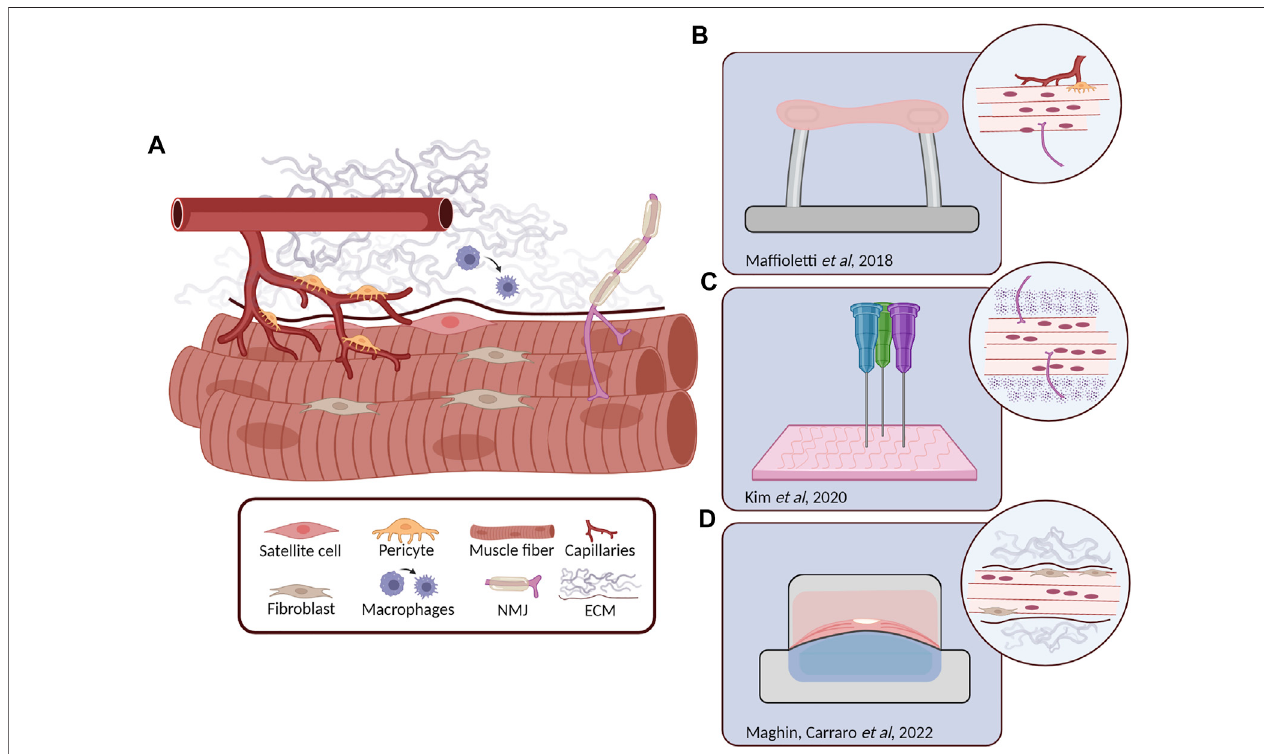
FIGURE2| Skeletalmuscle(SkM)structureandrelevant3Dtissueengineeredmodels. (A) SchematicrepresentationofthedifferentcelltypescomposingtheSkM tissue. Myo fi bers are surrounded by ECM proteins, satellite cells are retained underneath the basal lamina, fi broblasts are in close contact with myo fi bers as the motor neurons that form the neuromuscular junction (NMJ), while pericytes are coming from blood vessels. In the presence of muscle damage, macrophages are recruited to the site of injury where they differentiate from M1 to M2. (B) Human induced pluripotent stem (hiPS) derived cells (including myo fi bers, pericytes, endothelial cells andMN)embeddedina fi brinhydrogelmaintainedintensionbetweentwopillars.Microscopicanalysisrevealedthegenerationofstable3Dconstructswiththepresence of isogenic myo fi bers, vascular cells and motor neurons (Maf fi oletti et al., 2018). (C) 3D bioprinting approach for the generation of innervated myo fi bers following highly precise pattern design (Kim et al., 2020). (D) Transversal section of a custom-made bioreactor for the in vitro generation of diaphragmatic 3D models, after 14 days of dynamic culture the injected human primary SkM cells and fi broblasts displayed to colonize the proper ECM position, offering a possible solution for the generation of biological patches for the treatment of diaphragm defects (Maghin et al.,